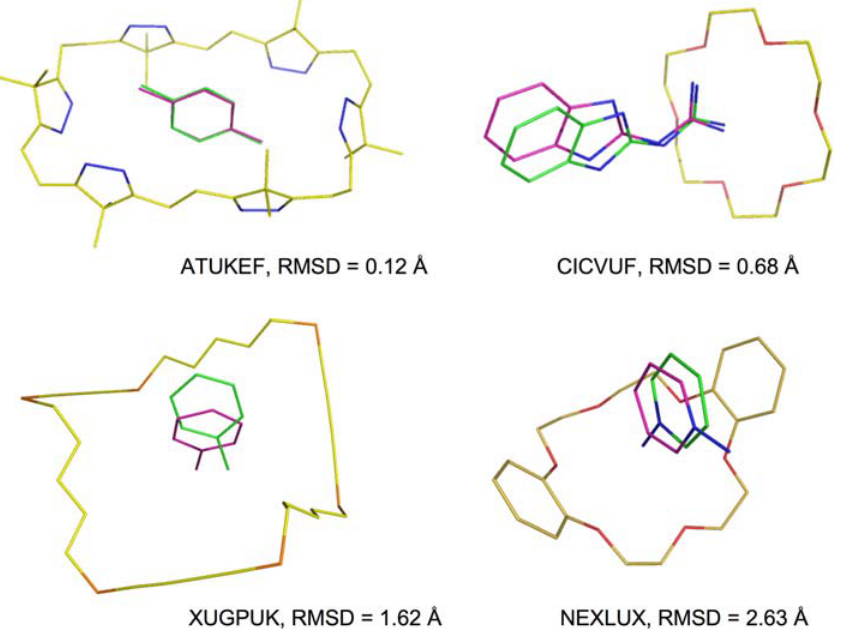
Figure 1. Overlays of the EUDOC-generated and crystal structures of complexes ATUKEF, CICVUF, XUGPUK, and NEXLUX. The C atoms of the EUDOC-generated and crystal structure are green and magenta, respectively. The O, N, and S atoms are red, blue and orange respectively. doi:10.1371/journal.pone.0000531.g001 Table 2. The Number and percentage of the EUDOC- generated complexes distributed in four categories of the